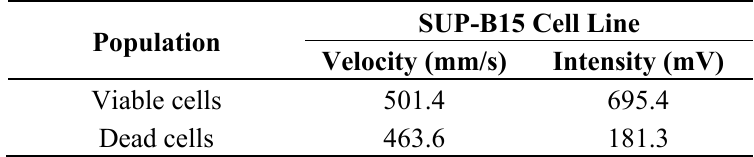
Table 1. Velocity and intensity for the SUP-B15 cell measurement of Figure